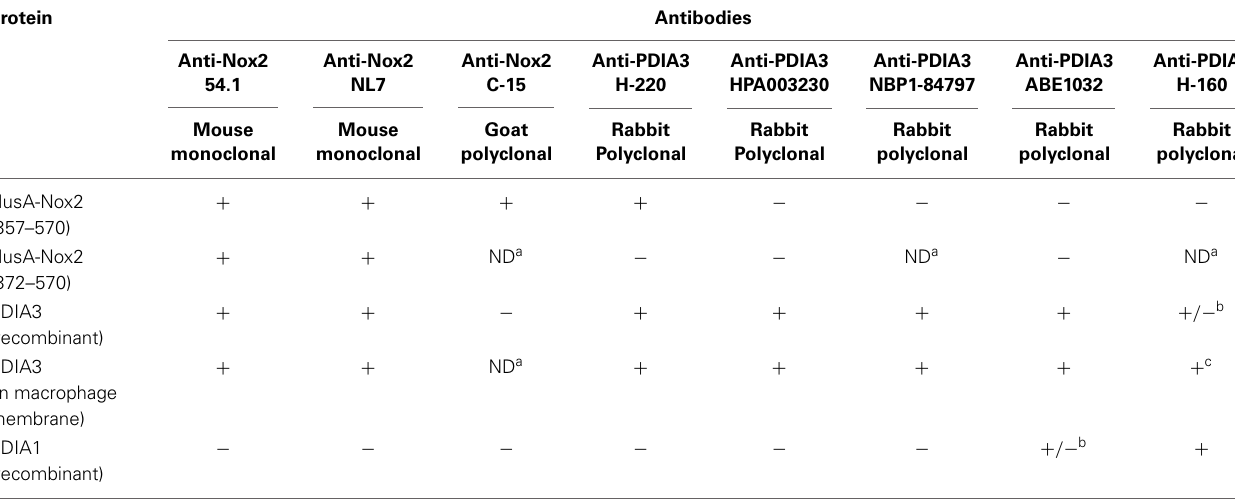
Table 1 | Cross-reactivity of some anti-Nox2 antibodies with PDIA3 and of some anti-PDIA3 antibodies with Nox2.